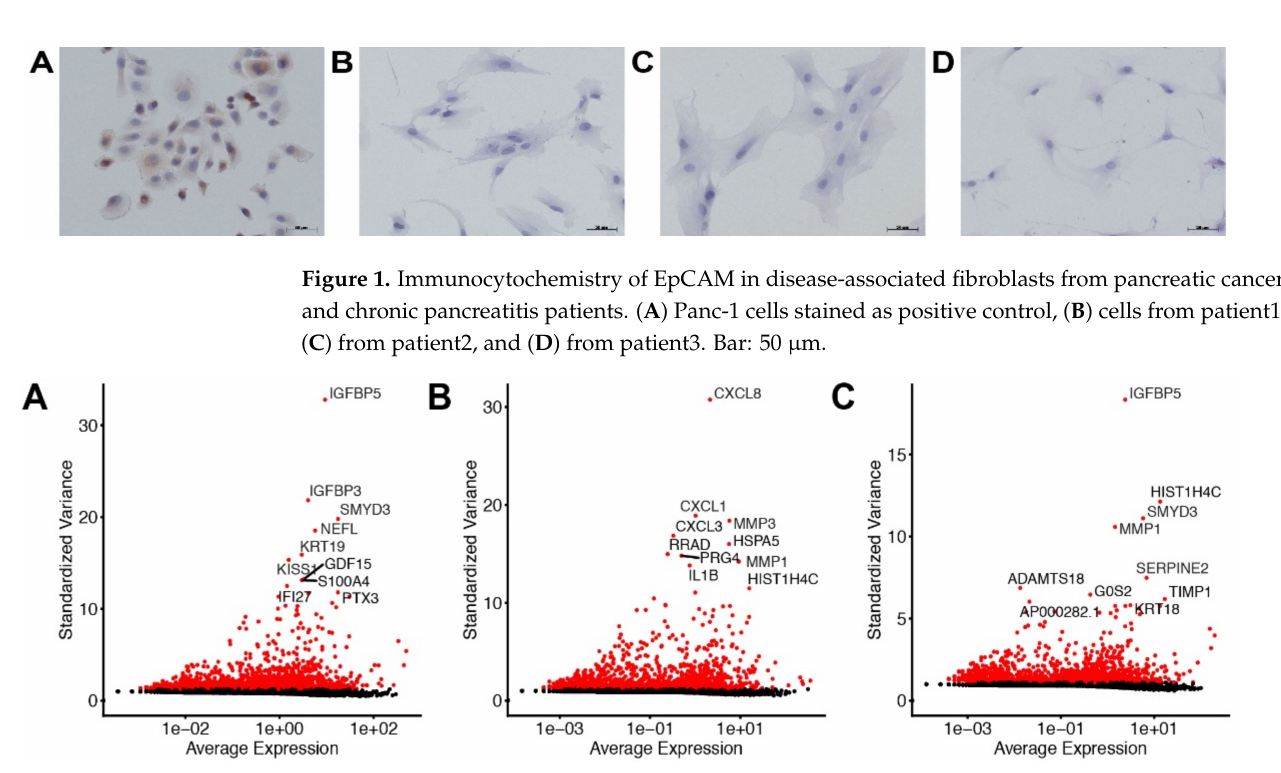
Figure 2. Highly variable features in disease-associated fibroblasts from pancreatic cancer and chronic pancreatitis patients. A subset of features that exhibit high variation between cells in disease- associated fibroblasts ( A ) from patient1, ( B ) from patient2, and ( C ) from patient3.